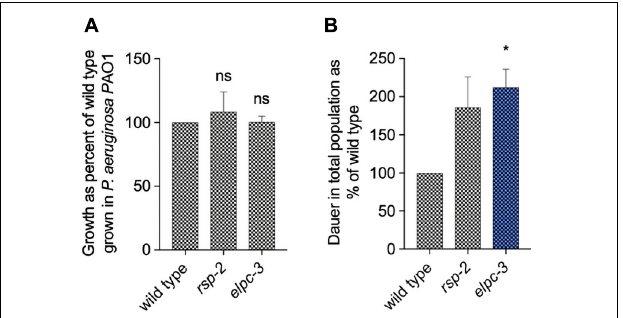
FIGURE 7 | Growth (A) and diapause formation (B) of wild-type, elpc-2 , and rsp-2 C. elegans mutants on P. aeruginosa PAO1 for two generations. * P <